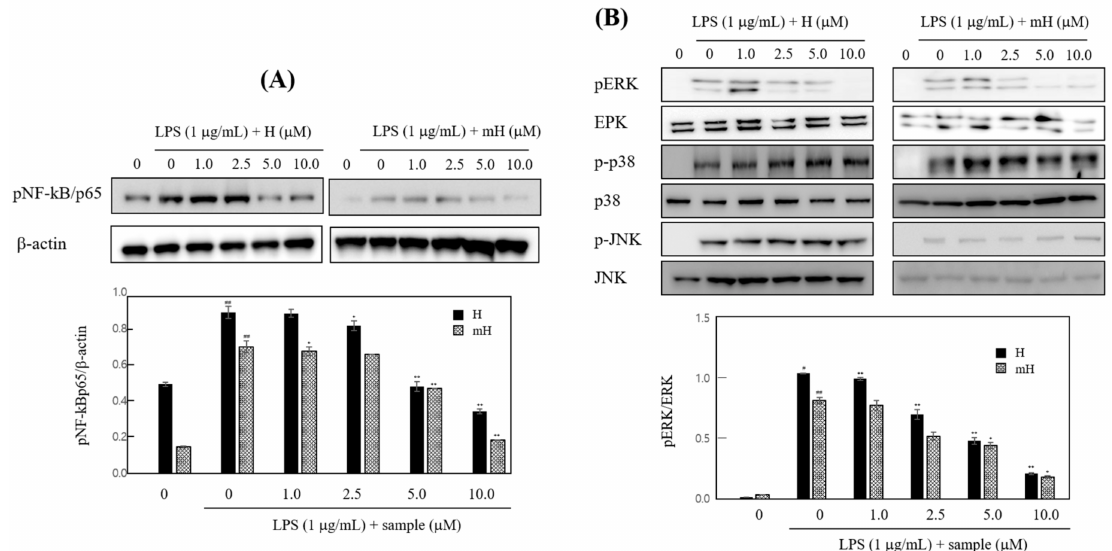
Figure 7. Effects of H and mH on nuclear factor- κ B (NF- κ B) ( A ) and mitogen-activated protein kinase (MAPK) ( B ) activation. Cells were cultured in the presence of H and mH for 24 h and then stimulated with LPS (1 µ g/mL) for 15 min under serum-free condition. The expression of NF- κ B and MAPK was detected by Western blot analysis. The relative density of phosphorylated NF- κ B (pNF- κ B) and phosphorylated extracellular regulated kinase (pERK) was calculated as the ratio of each protein expression to β -actin and ERK, respectively. # p < 0.05, ## p < 0.01 vs. control; * p < 0.05, ** p < 0.01 vs. LPS-treated